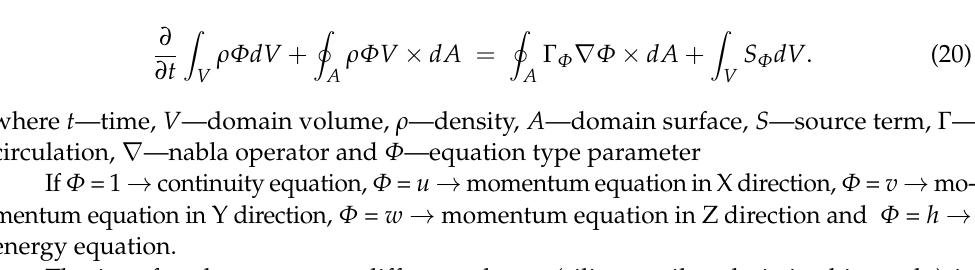
( a ) ( b ) Figure 9. Details of the numerical mesh with ( a ) surface mesh of the wider tube ‐ end and ( b ) boundary layer close to the wall. 4.2. Boundary Conditions and Material Properties Two simulation cases were performed on the tube geometry presented in Section 4.1. In the first case, called diffuser simulation, the “Inlet” boundary condition was defined on the tube end with smaller diameter, while the other end of the tube, with the larger diam ‐ eter, was set as “Outlet” boundary. In the second case, called confusor simulation, the roles of the boundaries are replaced according to Figure 10a,b. A total pressure of 21 bar on the “Inlet” boundary passes silicone oil at 80 °C, through the tube against the “Outlet” boundary that is at atmospheric pressure (1 bar).